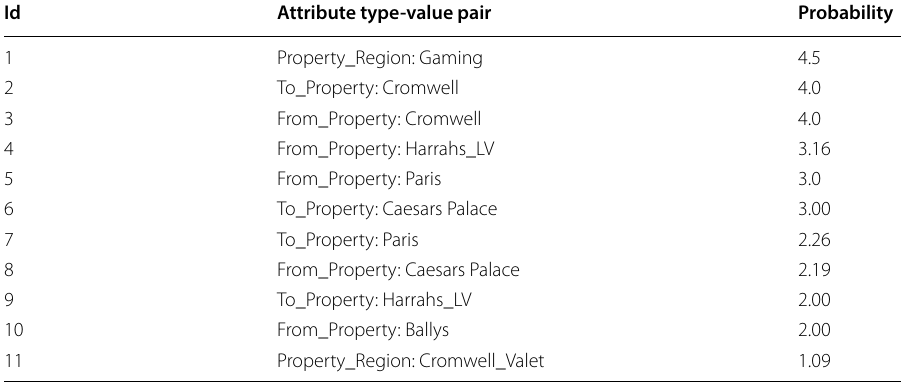
Table 12 Edge-weight for Caesars-WiFi dataset